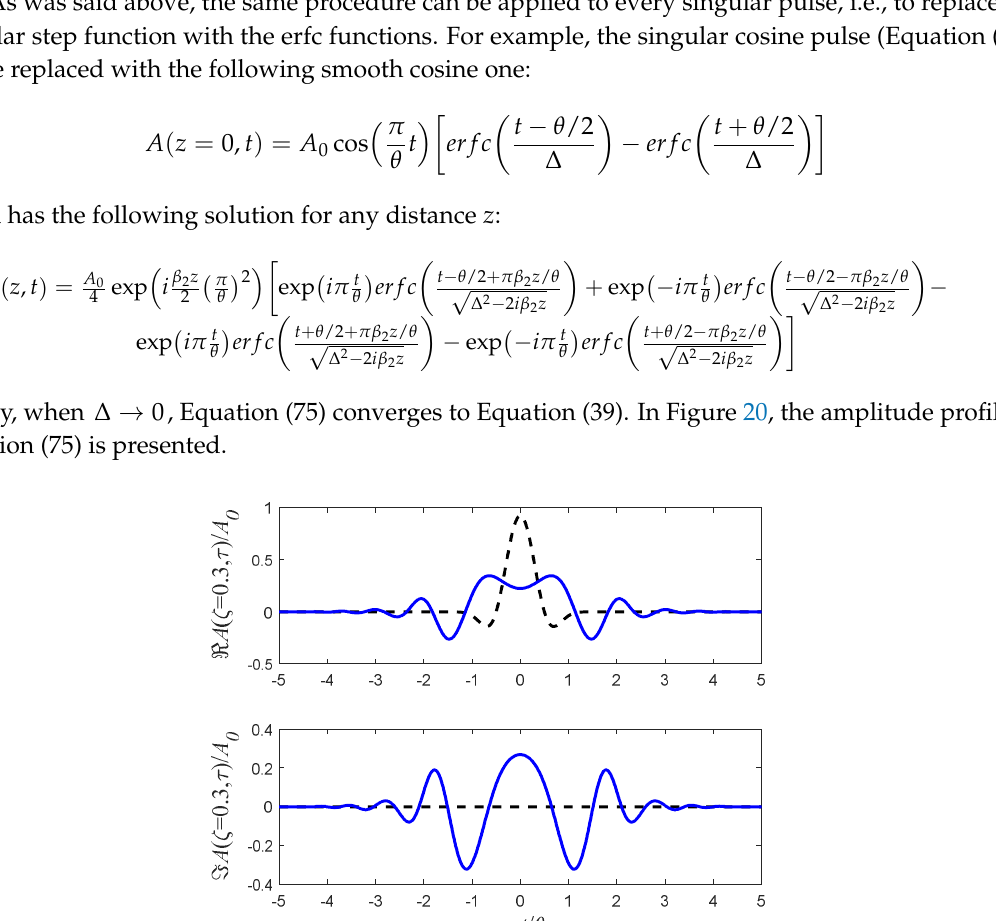
Figure 19. Same as Figure 8 but for a smooth rectangular pulse with  25.0 .